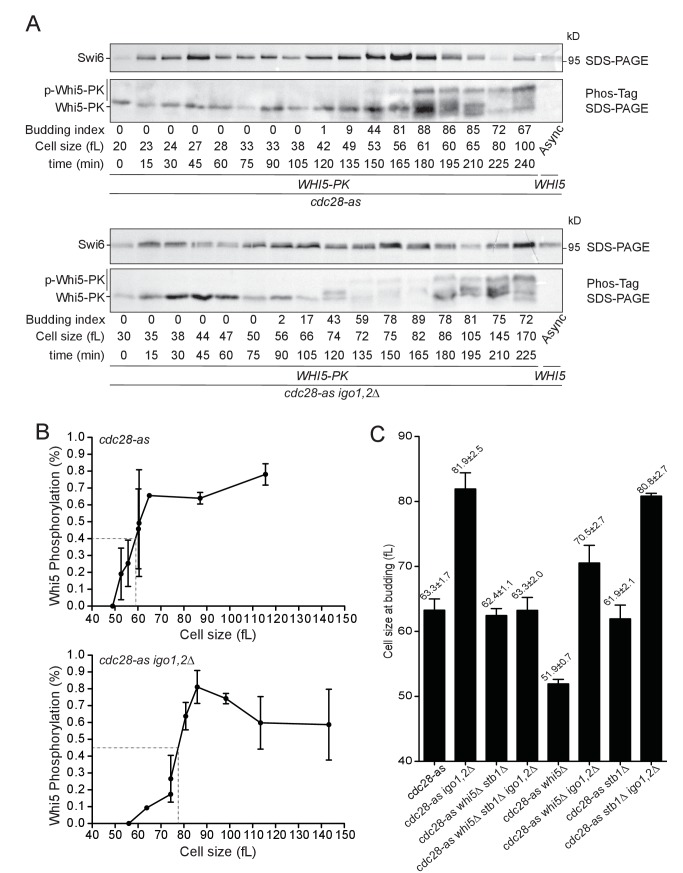
The Rim15 pathway controls START by promoting Whi5 phosphorylation.(A) Whi5 is phosphorylated at a larger cell size when Igo1,2 are missing. cdc28-as1 (E5443) and cdc28-as1 igo1,2∆ (E5441) containing PK-tagged Whi5 were elutriated and Whi5 phosphorylation timing determined on Phos-tag gels. Untagged WHI5 strain is shown as negative control for antibody specificity. (B) Quantification of Whi5 phosphorylation from Phos-tag western blots. Mean (SD), n = 3. (C) The START delay of cdc28-as1 igo1,2∆ cells is dependent on WHI5 and STB1. Cells of the indicated genotype (E4479, E4458, E5222, E5218, E5188, E5227, E5189, E5221) were elutriated, early G1 cells incubated in SC-D at 30°C and the mean cell size at half maximum budding measured. Mean ±SD is indicated, n = 4.